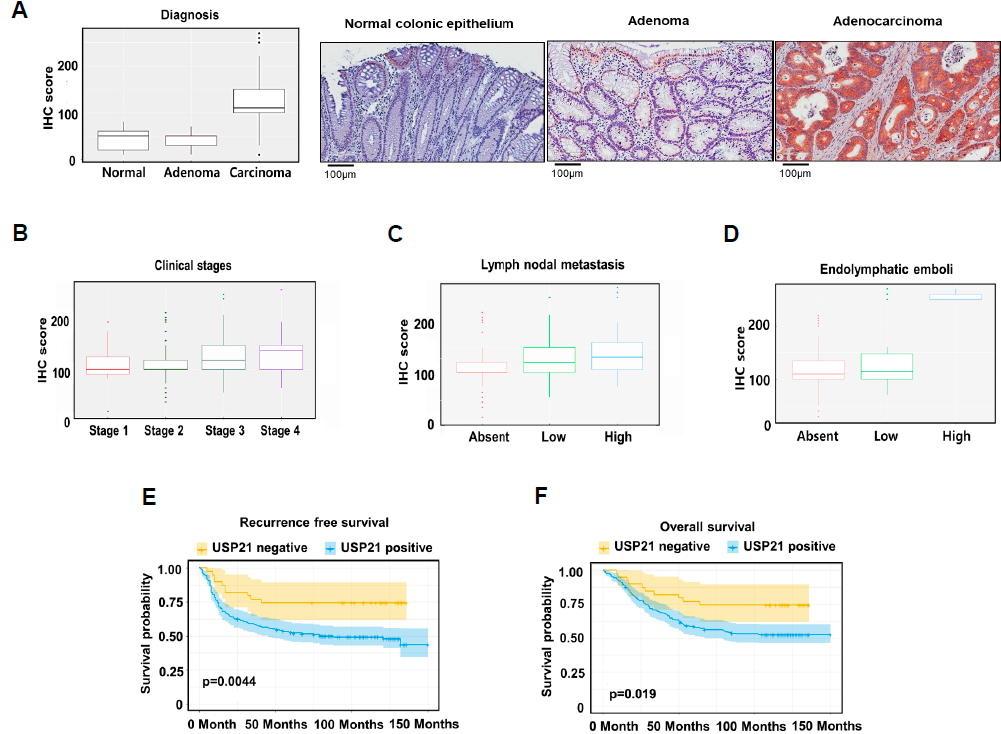
Figure 6. USP21 expression is highly correlated with cancer progression in colon cancer patients. ( A , B ) The expression of USP21 protein following the Oncotype DX assay (A, left) and according to tumor stage in CRC patients (B). Data were statistically analyzed by SPSS (version 18.0). Representative IHC images of USP21 expression in CRC patient samples (A, right). ( C , D ) Correlation of USP21 expression with nodal metastasis of CRC (C) and with endolymphatic emboli of CRC (D). Chi-squared tests (Pearson’s Chi-squared test or Chi-squared test using linear by linear association) were used to analyze correlations between IHC results and clinicopathologic parameters. ( E , F ) Kaplan–Meier